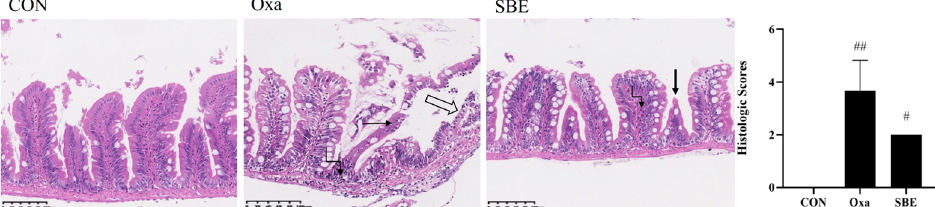
Figure 2. Effects of SBE on the intestinal tissue of zebrafish. Representative hematoxylin and eosin (H&E)-stained intestinal sections and semiquantitative scoring showed tissue damage. The values are expressed as the mean ± SD. (n = 3). The thin black arrows represent degeneration, necrosis, and detachment of mucosal epithelial cells. The hollow arrows represent the exposed muscle layer. The folded arrow represents neutrophil infiltration. Thick black arrows represent villi breakage. Groups with different letters statistically differ (compared with the CON group, # p < 0.05, ## p < 0.01).